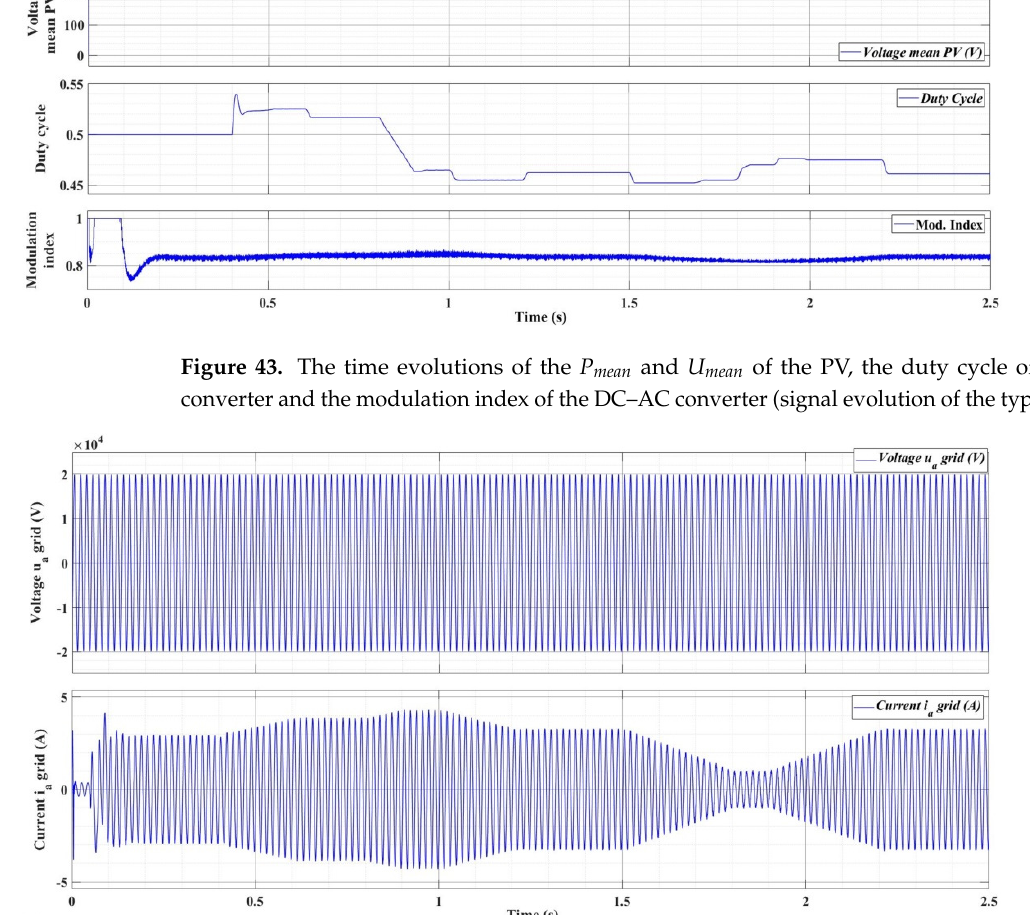
Figure 44. The time evolution of the u a voltage and i a current of the main grid (signal evolution of the type 2 PV array).